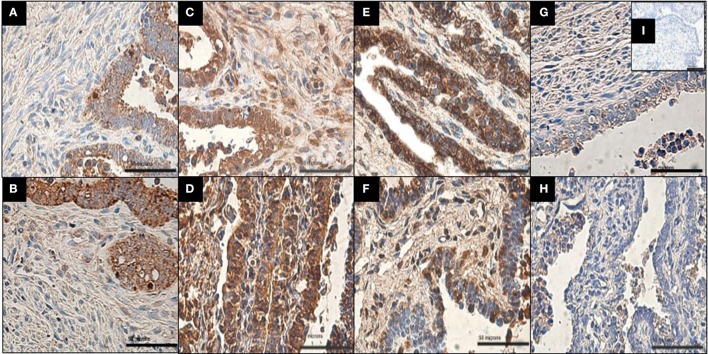
Immunolocalization of MMP-9, MMP-3, MMP-8, and TIMP-1 in infected and uninfected explants. (A,C,E,G) Show uninfected explant expression of MMP-9, MMP-3, MMP-8, and TIMP-1, respectively. (B,D,F,H) Show infected explant expression of MMP-9, MMP-3, MMP-8, and TIMP-1. All of the proteins were detected in the stroma and epithelial cells in both conditions. Note that MMP-8 shows markedly increased immunoreactivity in stroma after Ngo challenge and less immunoreactivity in epithelial cells than in uninfected explants (n = 4). Scale bar = 50 μm. Negative control (I) shows no staining.